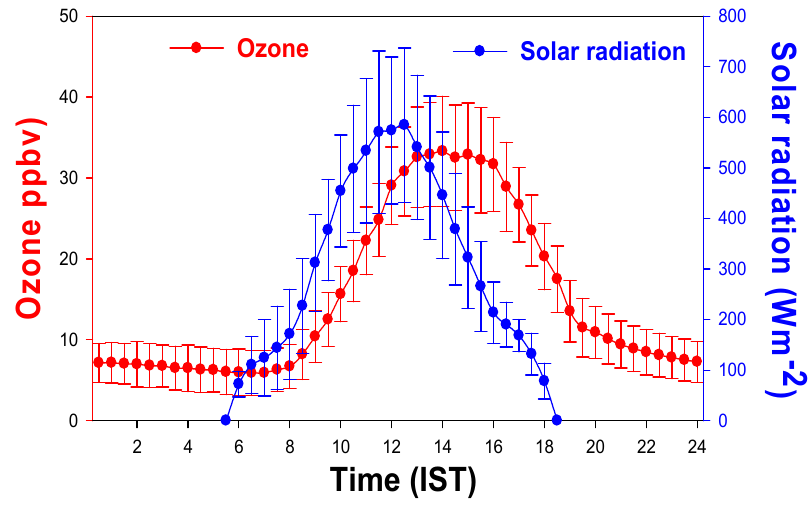
Figure 2. Diurnal variation of O 3 and solar radiation.